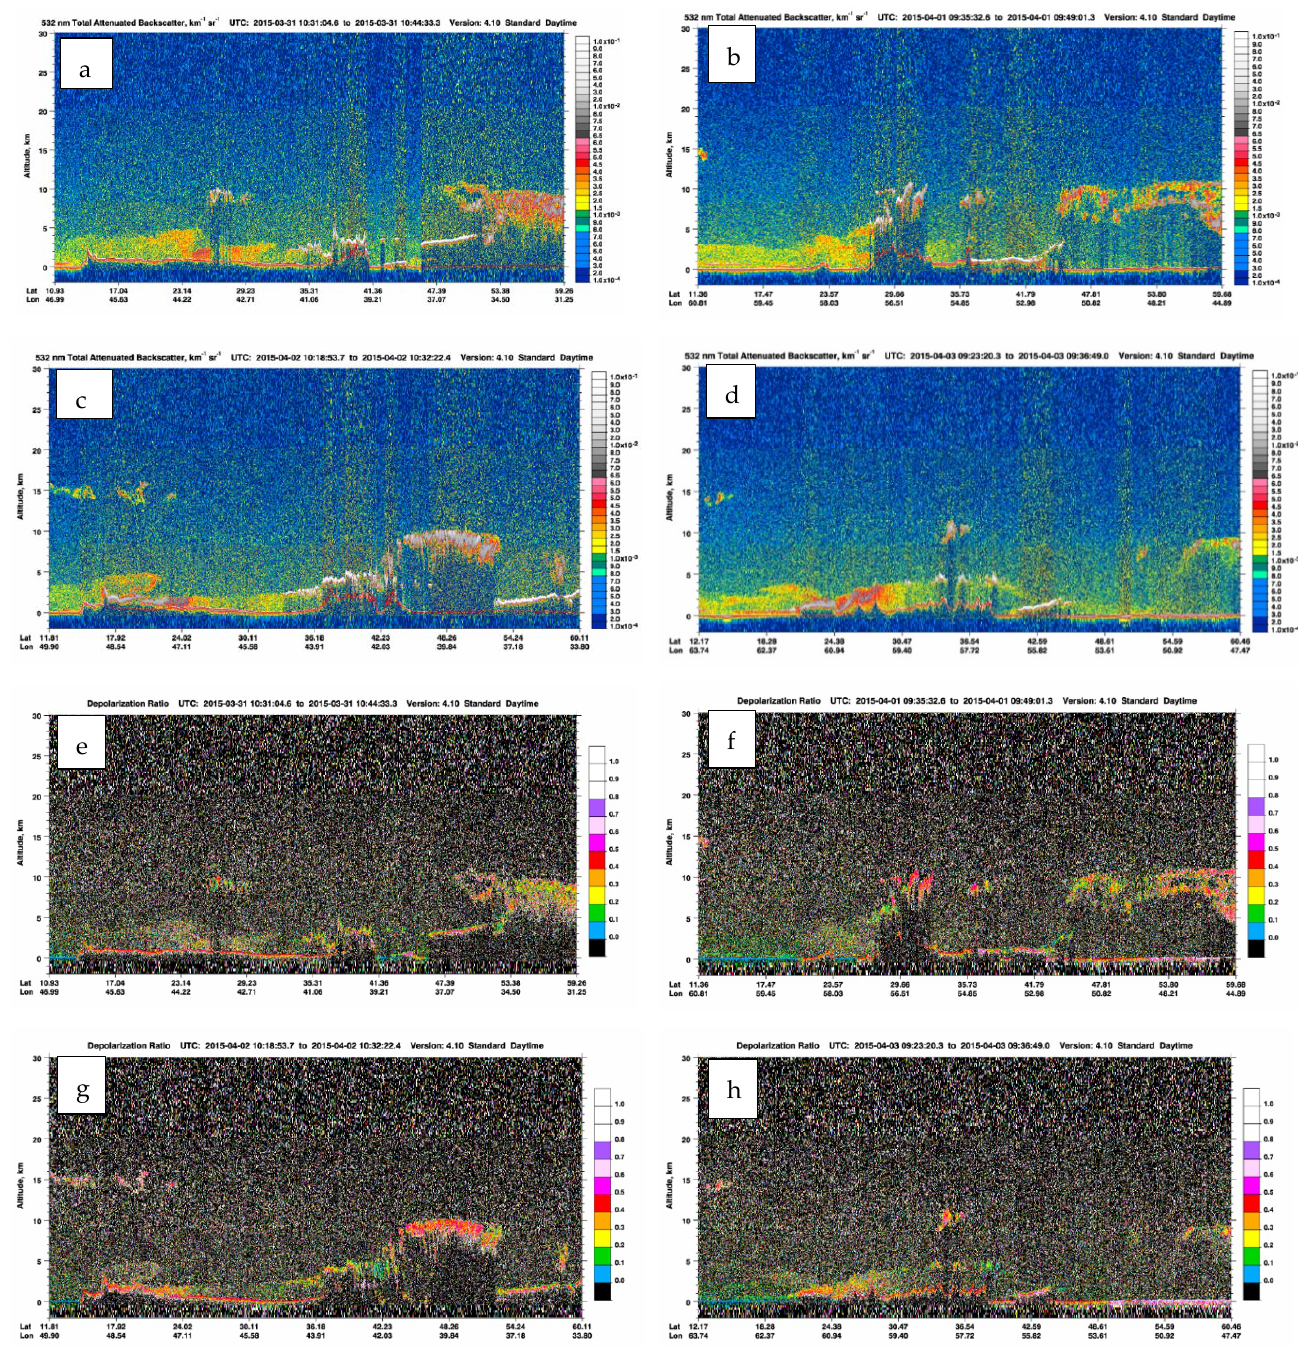
Figure 6. Showing 532 nm total attenuated backscatter (km − 1 sr − 1 ) (31 March 2015–3 April 2015: ( a – d )), and depolarization ratio (31 March 2015–3 April 2015: ( e – h )).